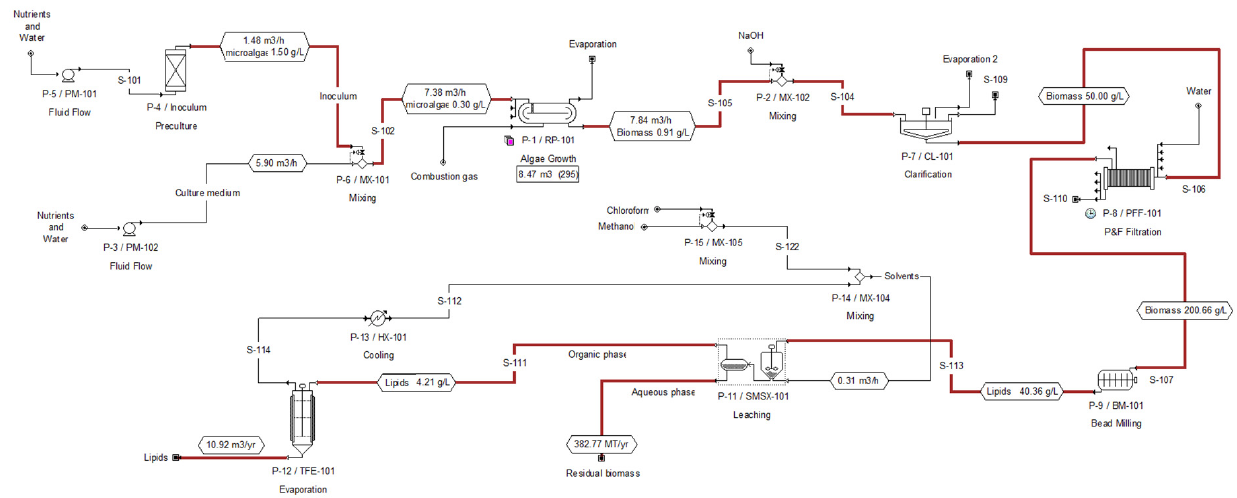
Figure 2. Flowsheet in SuperPro Designer for lipid production from wet biomass, scenario 1.